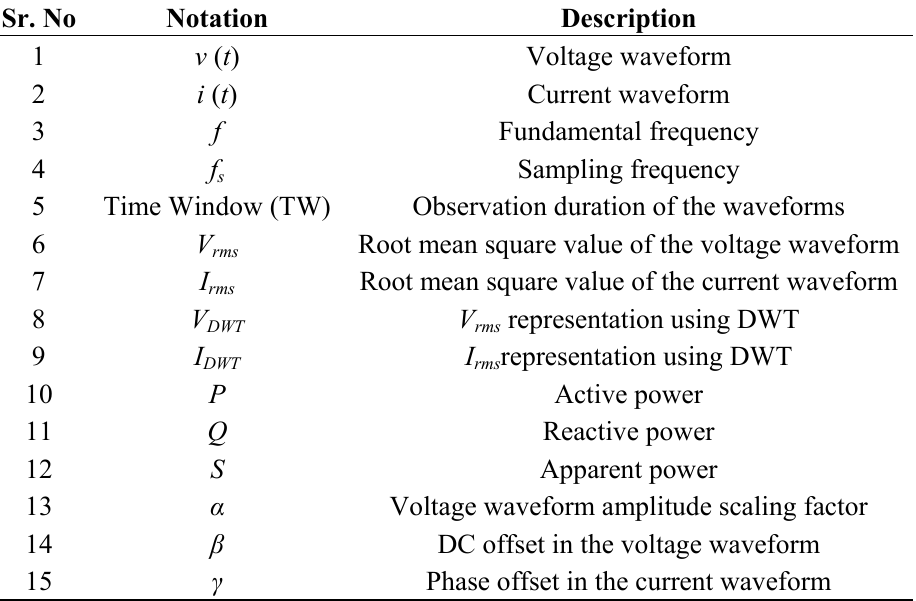
Table 1. Nomenclature.